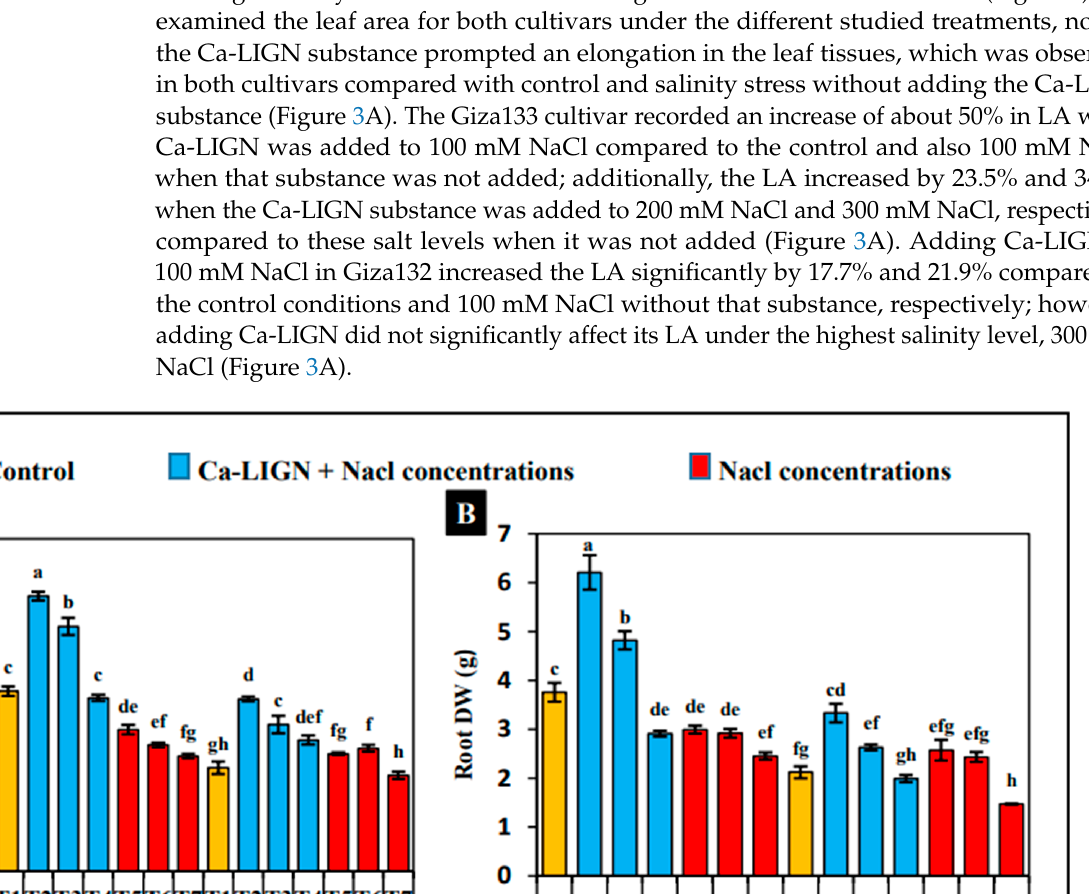
Figure 2. Effect of different treatments: (T1) control, (T2) 100 mM NaCl + Ca-LIGNO, (T3) 200 mM NaCl + Ca-LIGNO, (T4) 300 mM NaCl + Ca-LIGNO, (T5) 100 mM NaCl, (T6) 200 mM NaCl, and (T7) 300 mM NaCl on the average ( A ) shoot length and ( B ) root length of the two barley cultivars, Giza133 and Giza132, during two seasons, 2019/2020 and 2020/2021. Data represent the mean ± SE (n = 4). The same letter indicates no significant difference ( p ≤ 0.05).